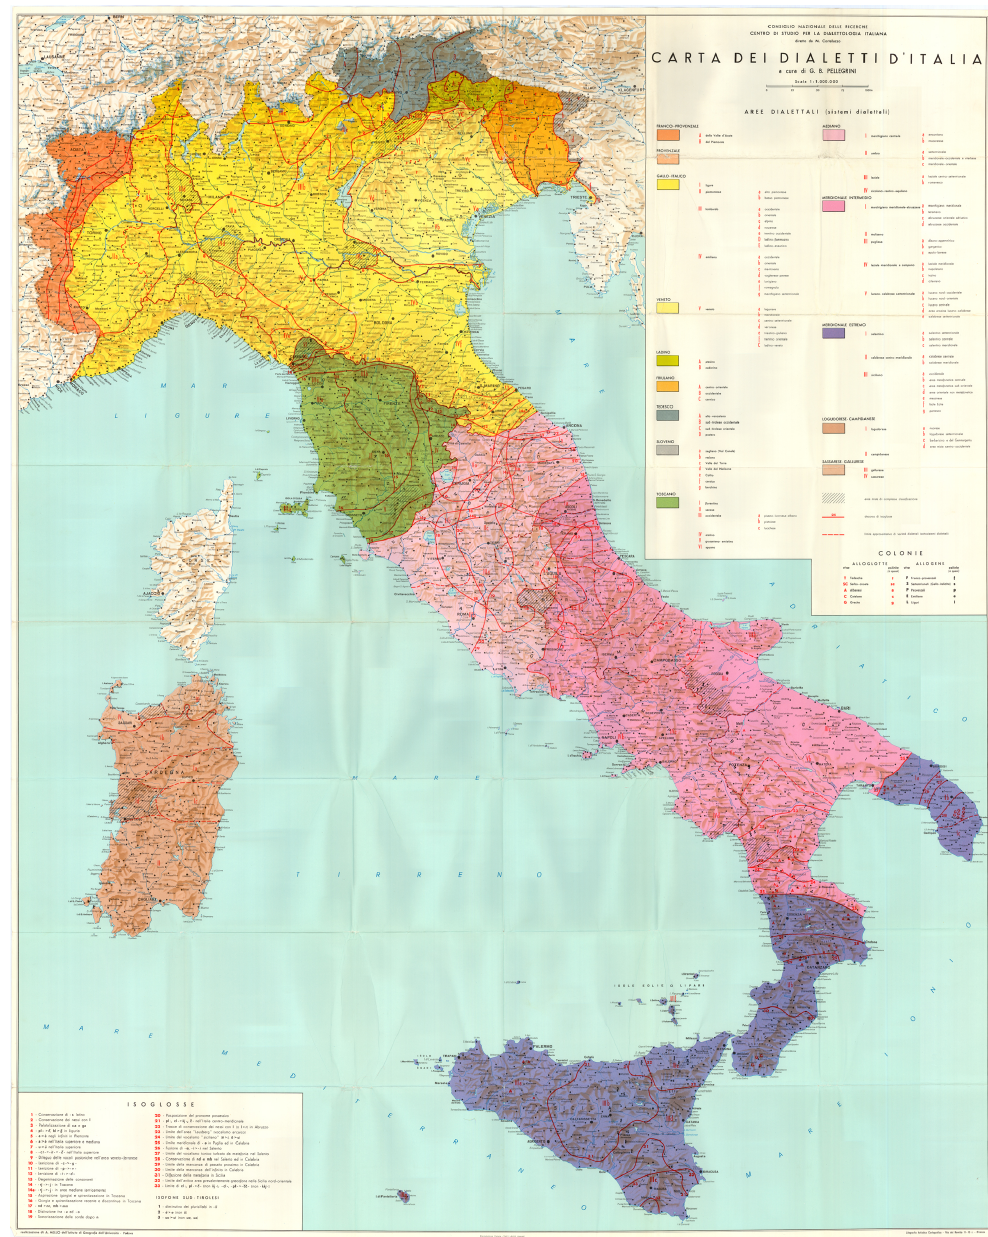
Figure 1. Map of local languages of Italy (Pellegrini 1977).